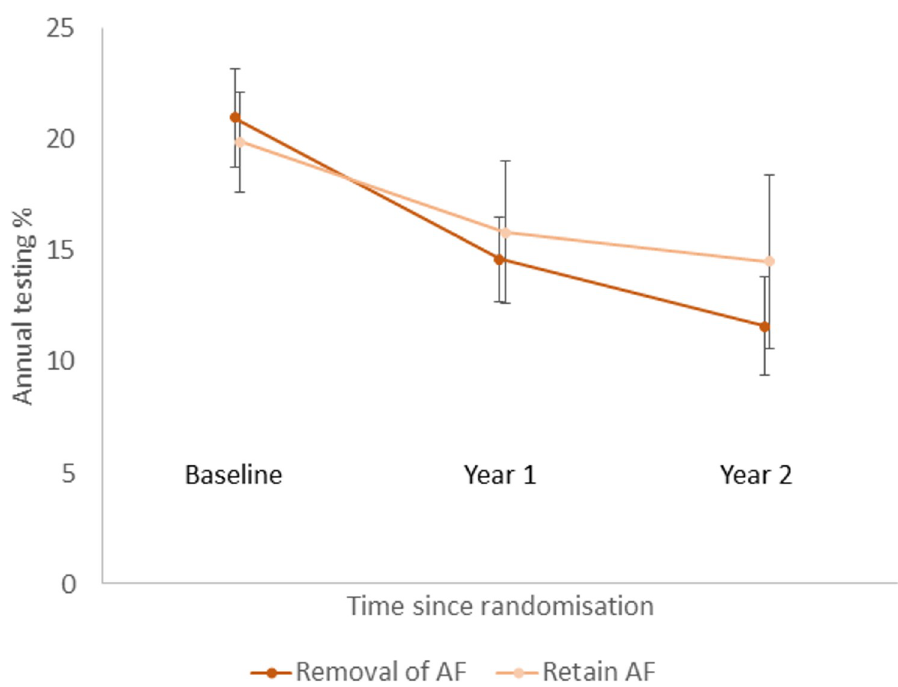
Fig 3. Proportion of patients tested for chlamydia per year by time since randomisation: Factorial analysis— removal of audit/feedback versus retention of audit/feedback. Error bars correspond to 95% confidence intervals. AF,